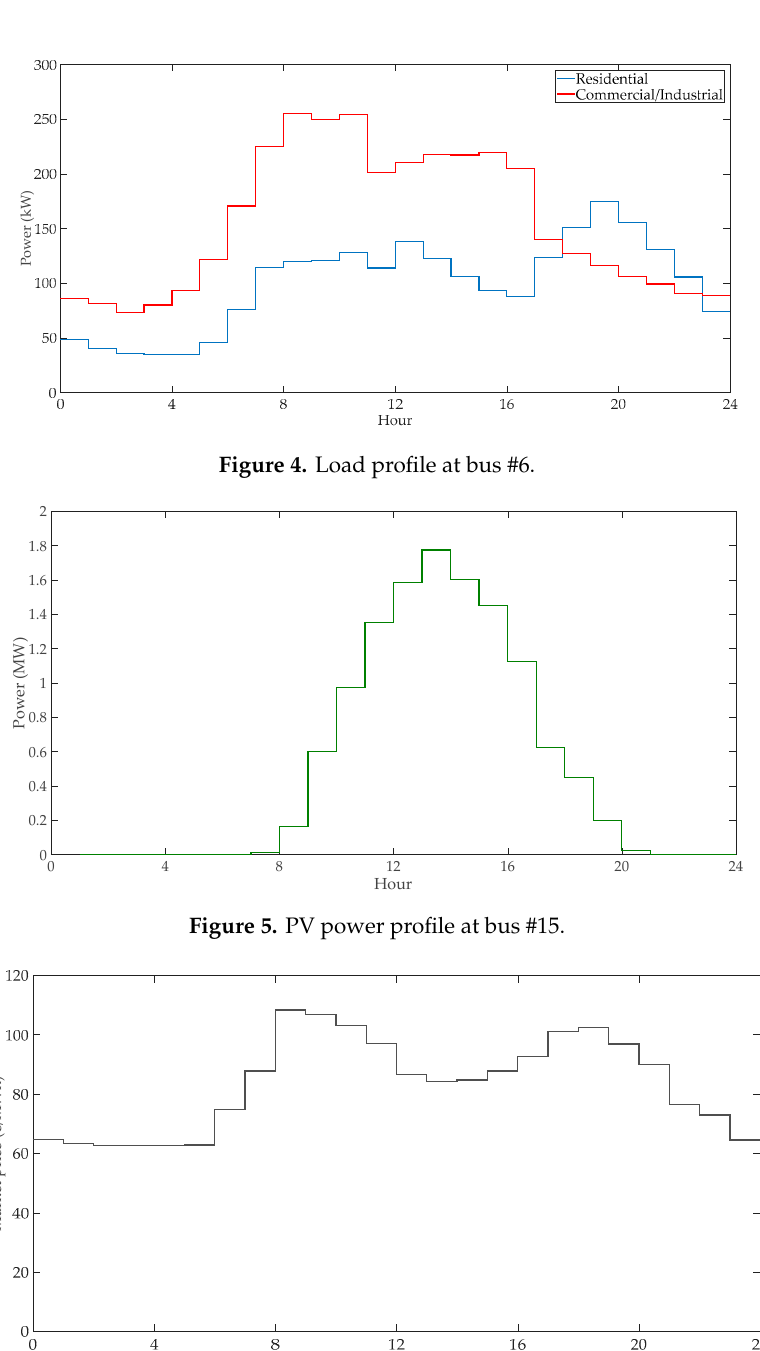
Figure 6. Market energy price (data taken from [36]).